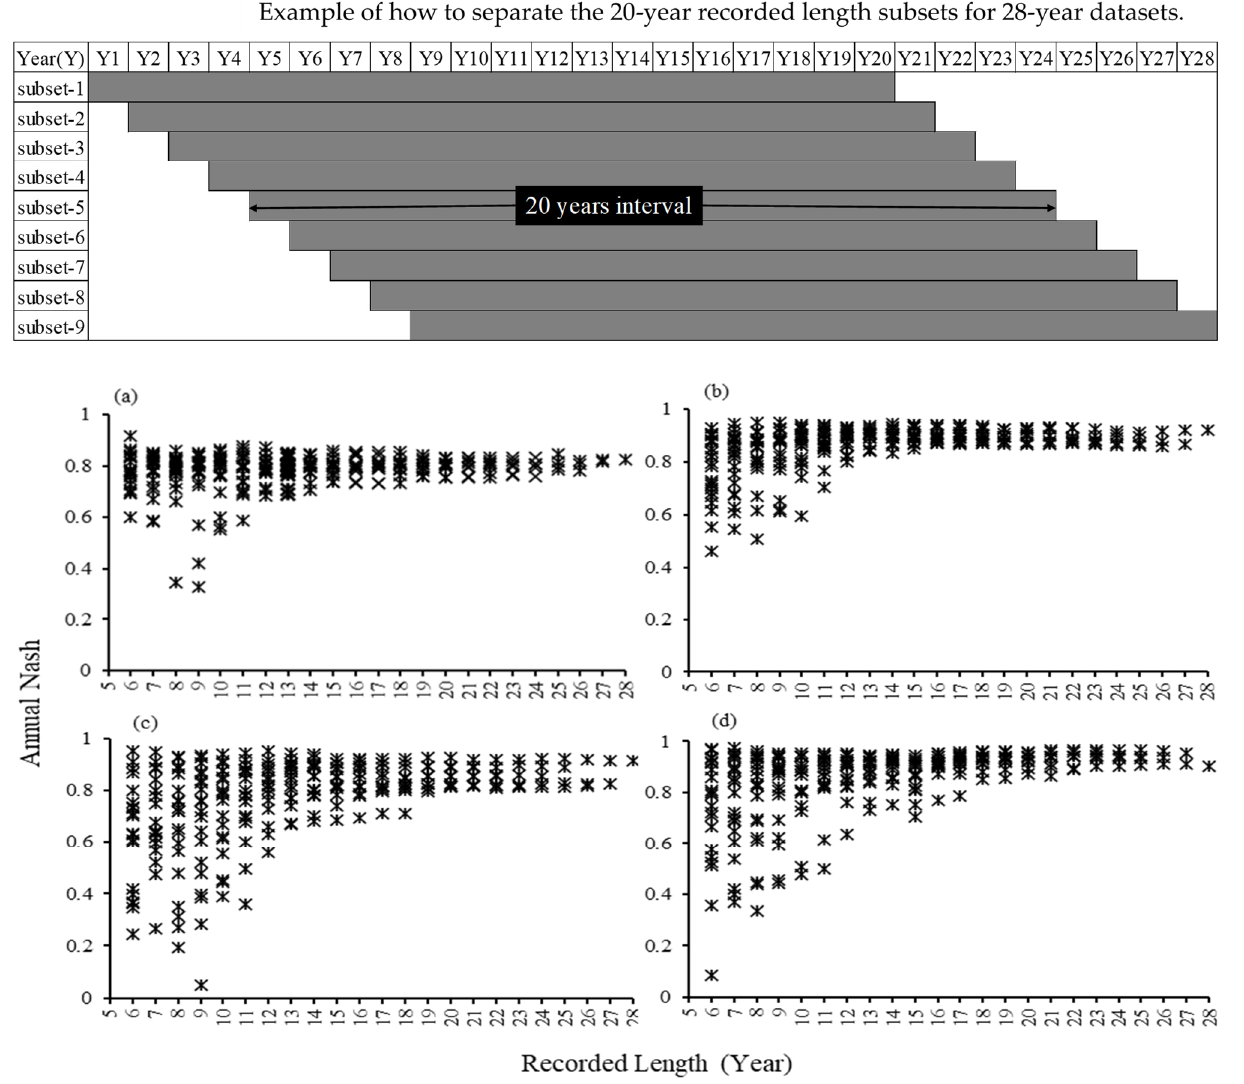
Figure 4. The values of annual Nash in subsets for ( a ) Doki River Basin ( b ) MOPEX ID 3504000 ( c ) MOPEX ID 2387500 and ( d ) MOPEX ID 2448000. Table 4. The numbers of subsets with n-year data length in 28-year datasets for all four River Basins